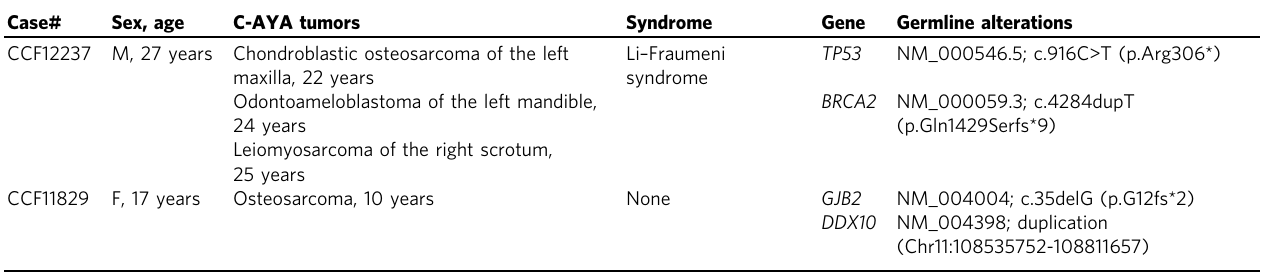
Table 1 CCF patients with germline alterations in known cancer-predisposing